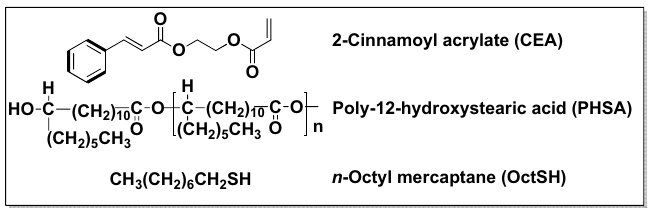
Figure 7. Dispersion polymerization procedure. The materials are introduced into a three-neck round bottom flask in three separate steps. Then, the contents are stirred for 1 h at 80 ◦ C, after which the solid contents of the dispersion are transferred into